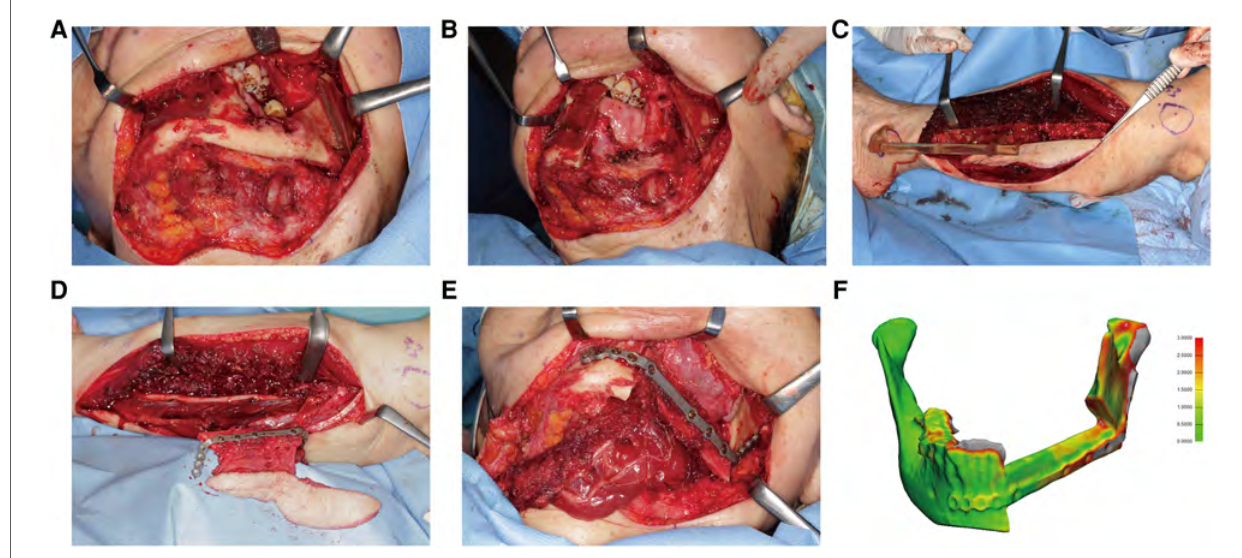
FIGURE 8 A 75-year-old female presented with osteoradionecrosis at the left mandible. ( A ) The mandible was exposed, and cutting guides were mounted to guide the segmental resection. Screw holes were drilled before osteotomy. ( B ) The mandible defect after resection was shown. ( C ) The fi bula free fl ap was harvested with the cutting guide. ( D ) The fi bula was fi xed to the PSSP. ( E ) The “ fi bula-plate ” was transferred to repair the mandibular defect. ( F ) The absolute distance deviation was 0.72±0.75 mm.